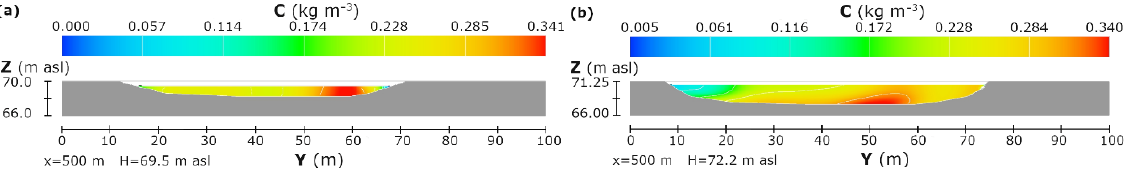
Figure 10: Distribution of the concentration of brine in the outlet cross section for (a) Q